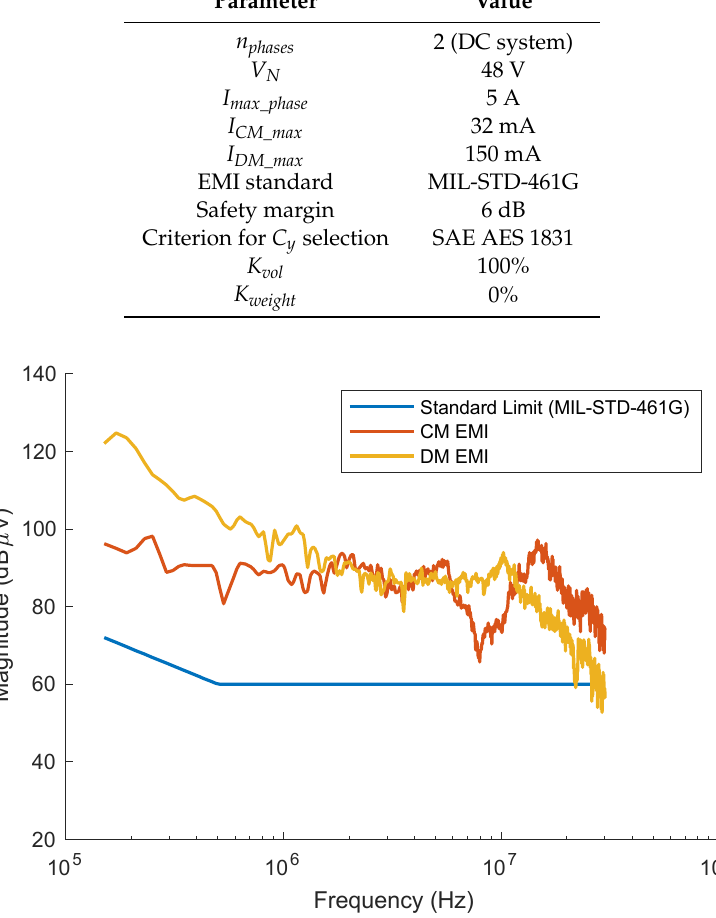
Figure 10. Standard limit superimposed to the measured CM and DM EMI spectra.